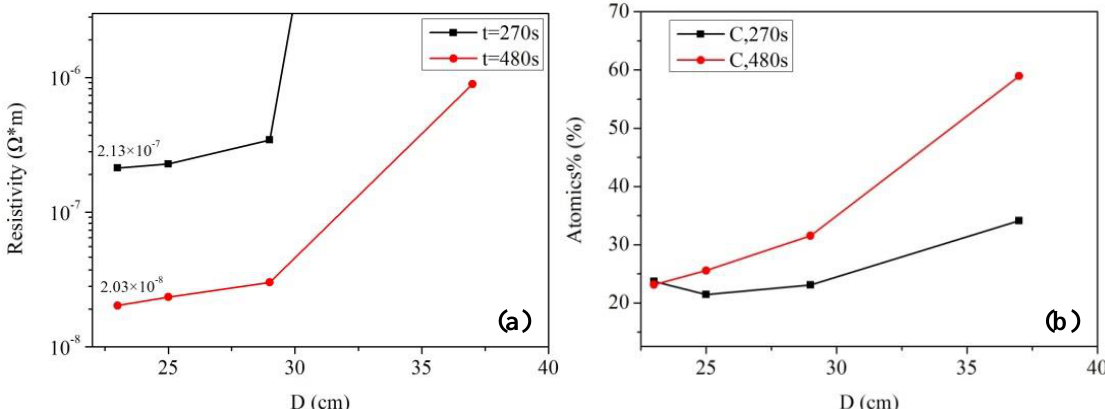
Figure 3. Electrical resistivity and carbon content of ultra violet (UV)-cured silver films based on MOD ink: ( a ) The electrical resistivity of silver films; ( b ) relative carbon content of silver films. D was defined as the distance between the samples and UV lamp.